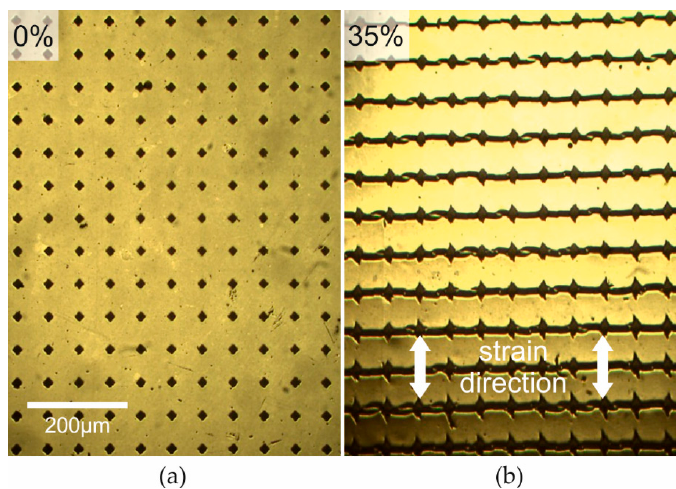
Figure 4. Optical micrographs of silver film deposited on the PDMS surface treated with UV (30 J ∙ cm − 2 ) including untreated soft islands (compare Figure 2a, top area, island distance: 45 μ m): before ( a ), and after, mechanical stretching by 35% ( b ).